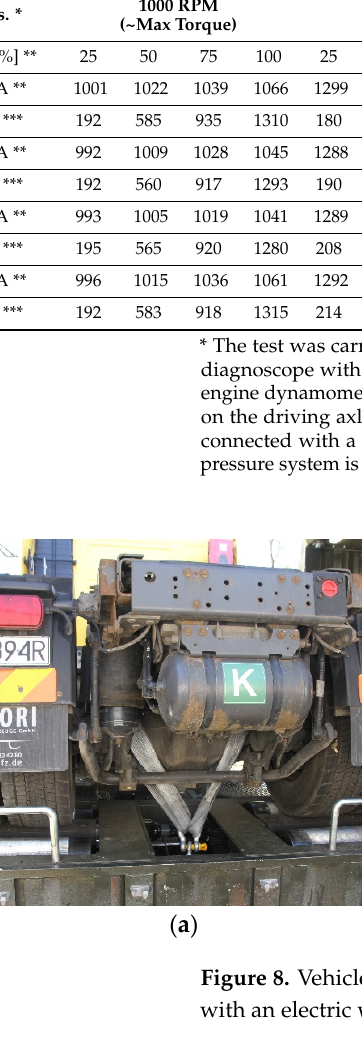
Table 6. Table of the results of tests of slip of tires on rollers.